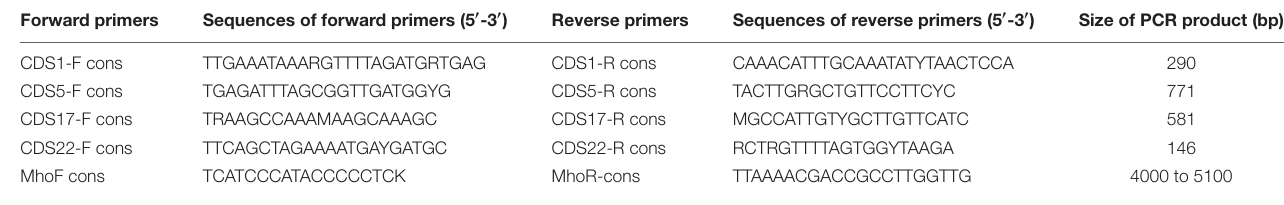
TABLE 2 | Primers used to detect the four ICE backbone CDSs (CDS1, CDS5, CDS17, CDS22) and the specific M. hominis ICE module. Forward